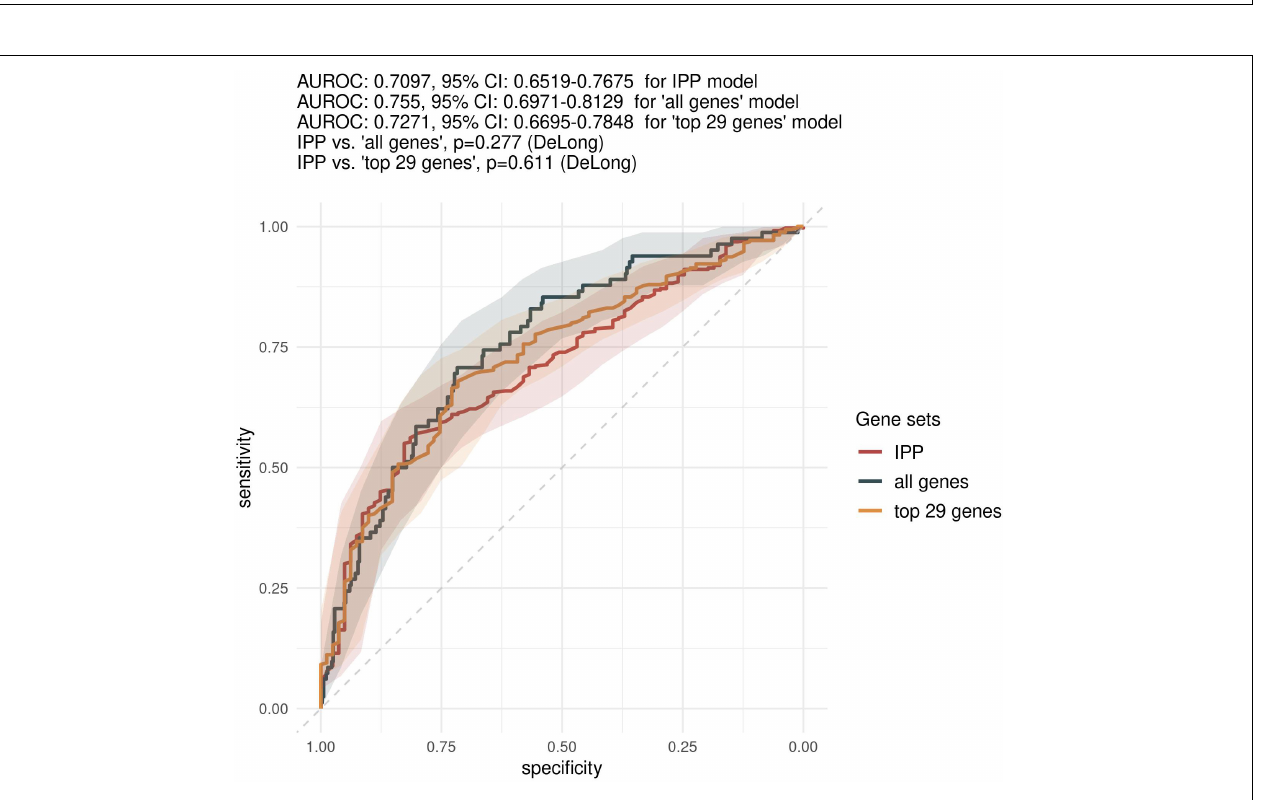
Frontiers in Medicine |